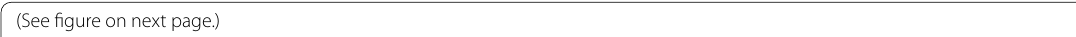
figure on next Fig. 7 Molecular phylogeny of 79Basidiomycota species based on Bayesian inference (BI) and Maximum likelihood (ML) analysis of 15 protein coding genes. Support values are Bayesian posterior probabilities (before slash) and bootstrap (BS) values (after slash).The asterisk on the evolutionary clades indicates that the BPP value is 1 and the BS value is 100.Species and NCBI accession numbers for mitogenomes used in the phylogenetic analysis are provided in Additional file 1: Table